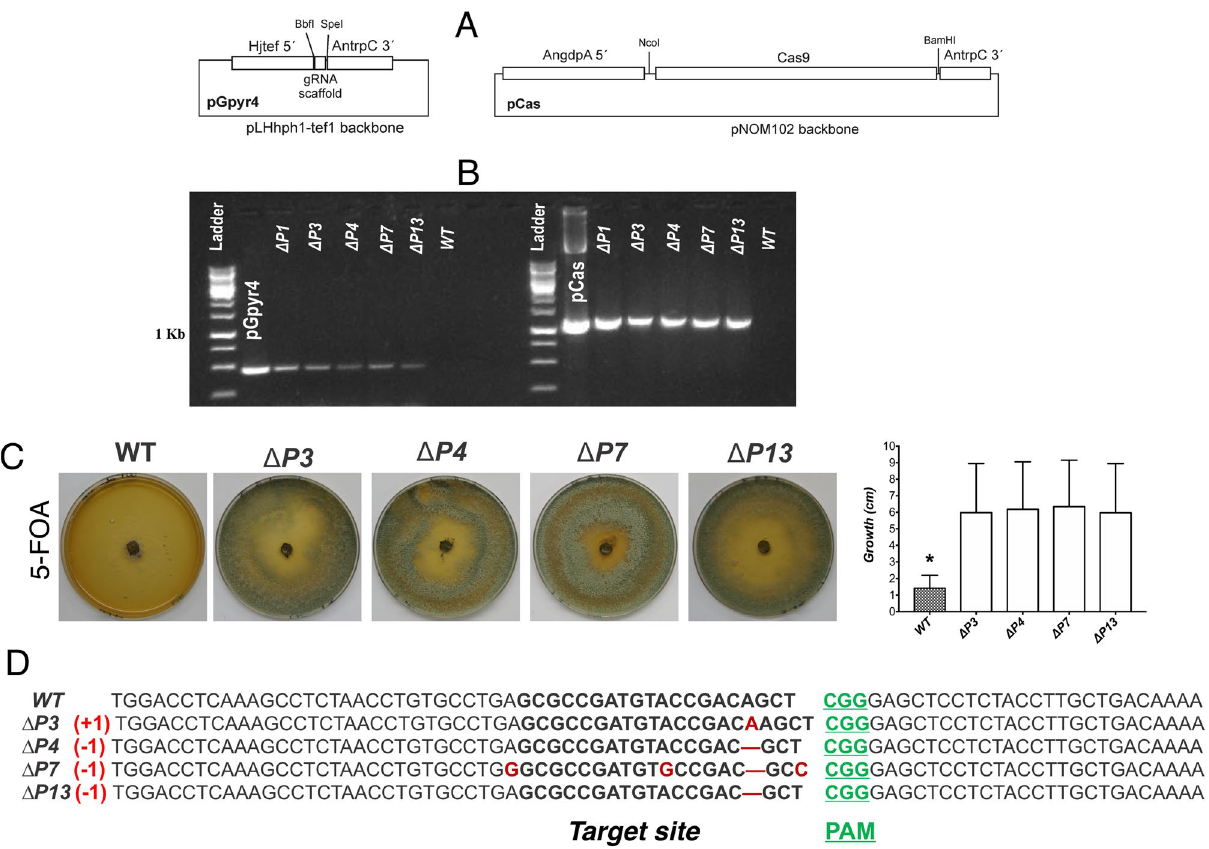
Figure 1. Screening of T. harzianum mutants resistant to 5 ′ -FOA. ( A ) Schematic representation of vectors used to transform fungus spores. ( B ) Genomic DNA of T. harzianum wild-type (WT) and FOA-resistant mutants ( ΔP3 , ΔP4 , ΔP7 , and ΔP13 ) was isolated and screened by PCR for the presence of the Cas9 gene which yielded a specific amplicon of 1242-bp. ( C ) Phenotype and growth of T. harzianum wild-type (WT) and FOA-resistant mutants ( ΔP3 , ΔP4 , ΔP7 , and ΔP13 ). *Bars marked with asterisk differ significantly ( P < 0.05). ( D ) A fragment from pyr4 , which was used for sequencing, confirmed mutants’ indels at target region. The sgRNA guiding sequence is highlighted in